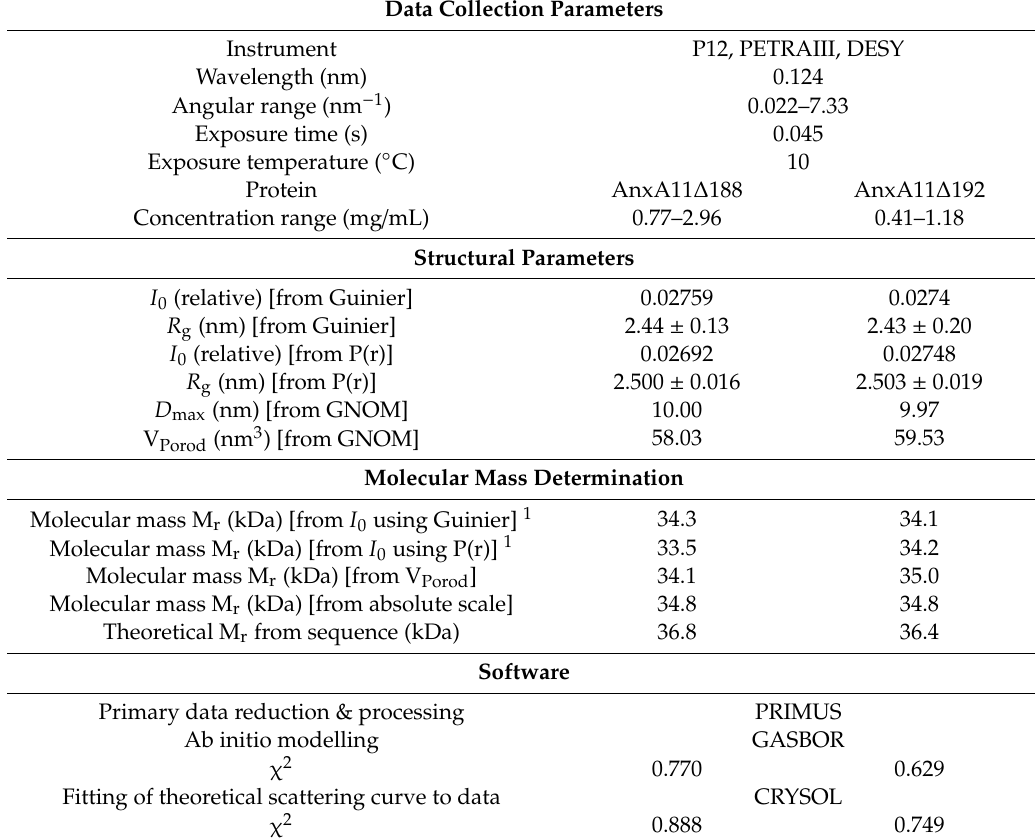
Table 1. Small-angle X-ray scattering parameters and